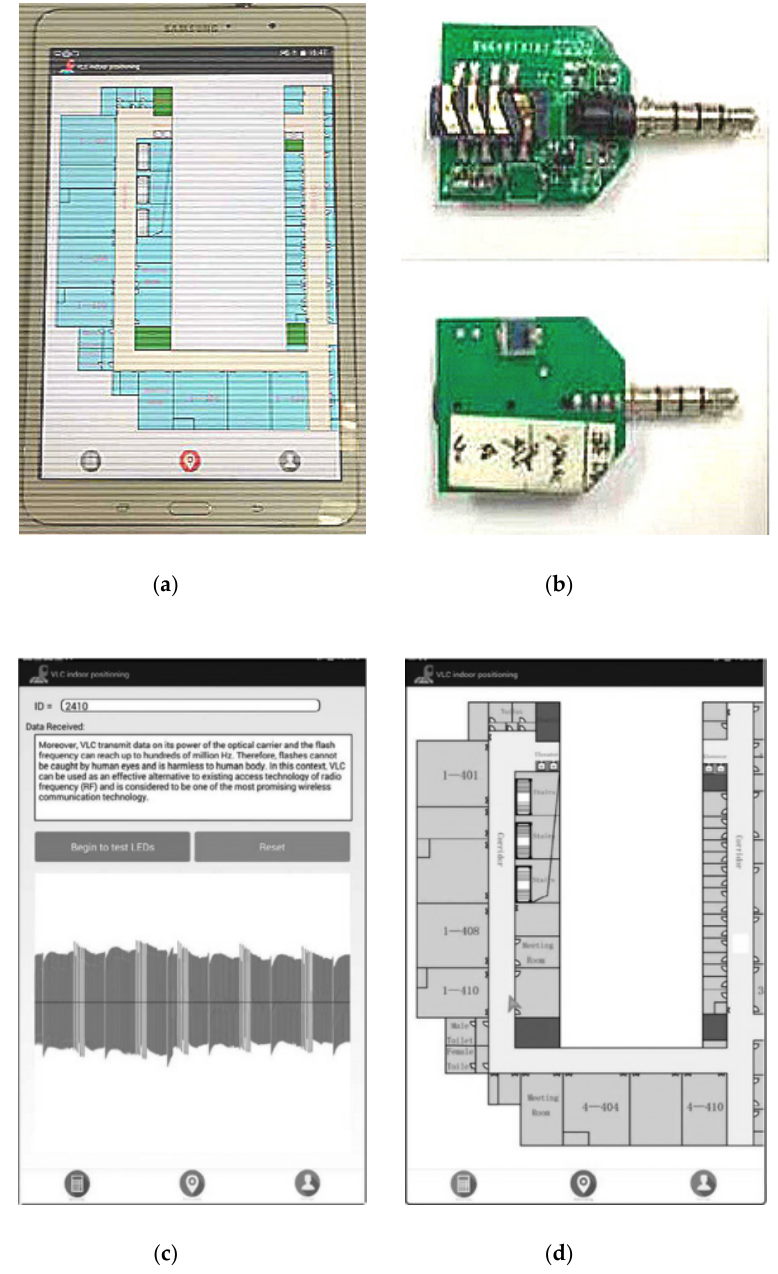
Figure 17. Demo and Android APP for indoor localization based on IWOC: ( a ) demo [12]; ( b ) receiver (back and front) [12]; ( c ) signal detection in the Android APP [16]; ( d ) map localization in the Android APP [19].